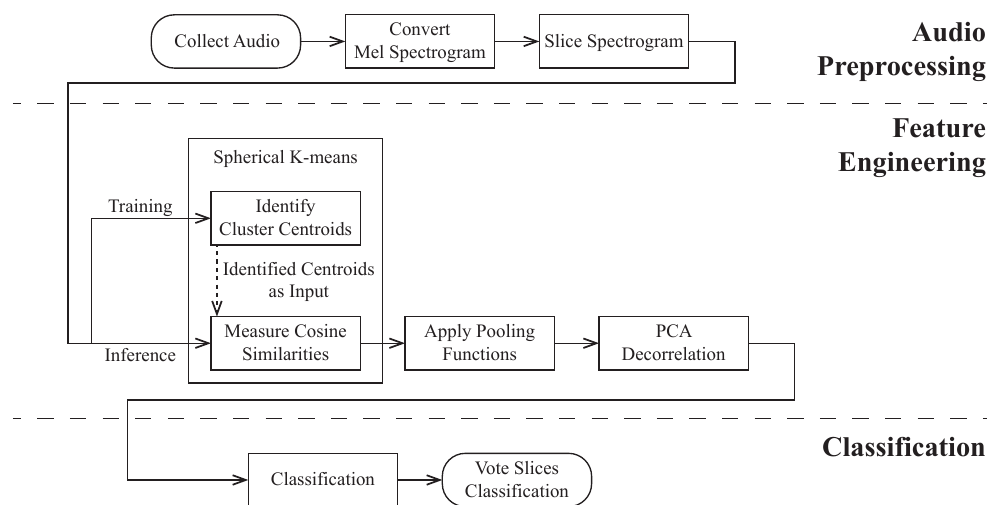
Figure 1. Flowchart of the proposed data pipeline showing how collected audio is classified positively or negatively as